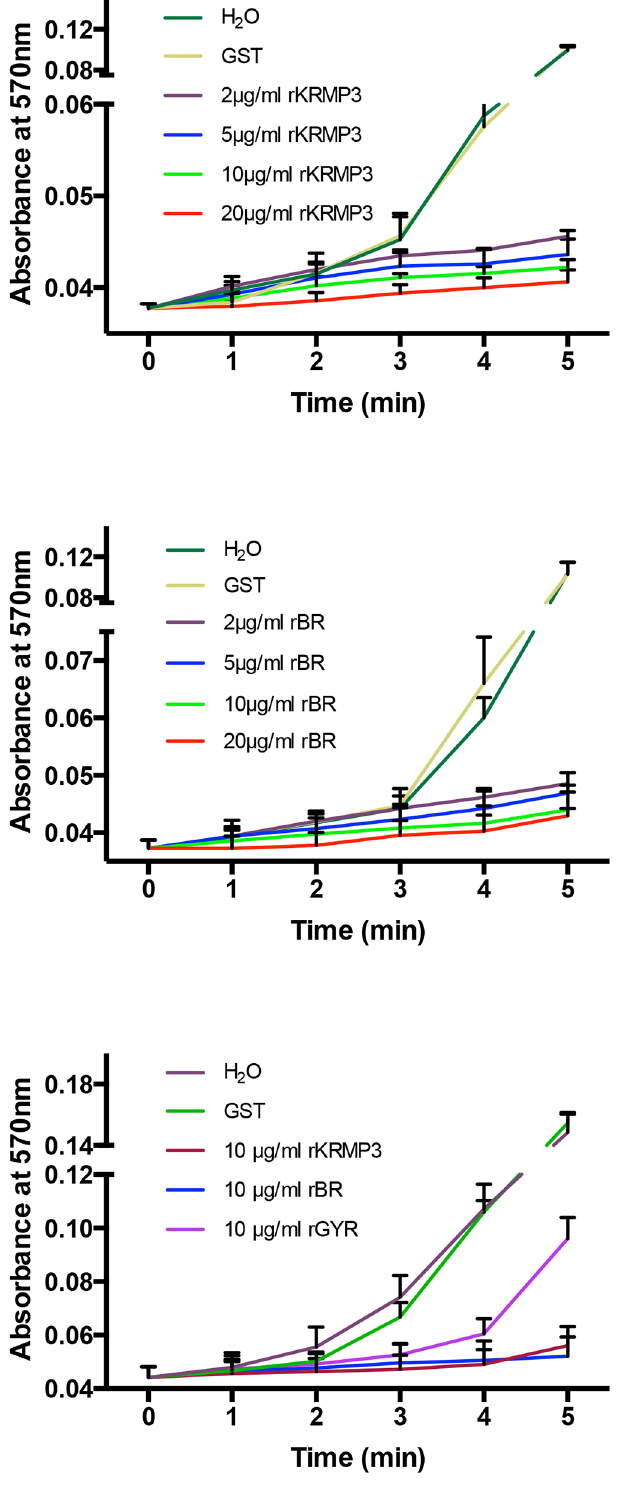
Fig 7. In vitro inhibition of CaCO 3 precipitation of by rKRMP-3 (A), rBR (B) and rGYR. 2 μ g/ml rKRMP-3 and rBR is effective to inhibit the precipitation and the inhibitory activity is dose-dependent. Inhibitory activity of 10 μ g/ml rKRMP-3 is almost the same as 10 μ g/ml rBR, while the activity of 10 μ g/ml rGYR is lower (C). 20 μ g/ml GST had no effect on the precipitation of calcium carbonate.